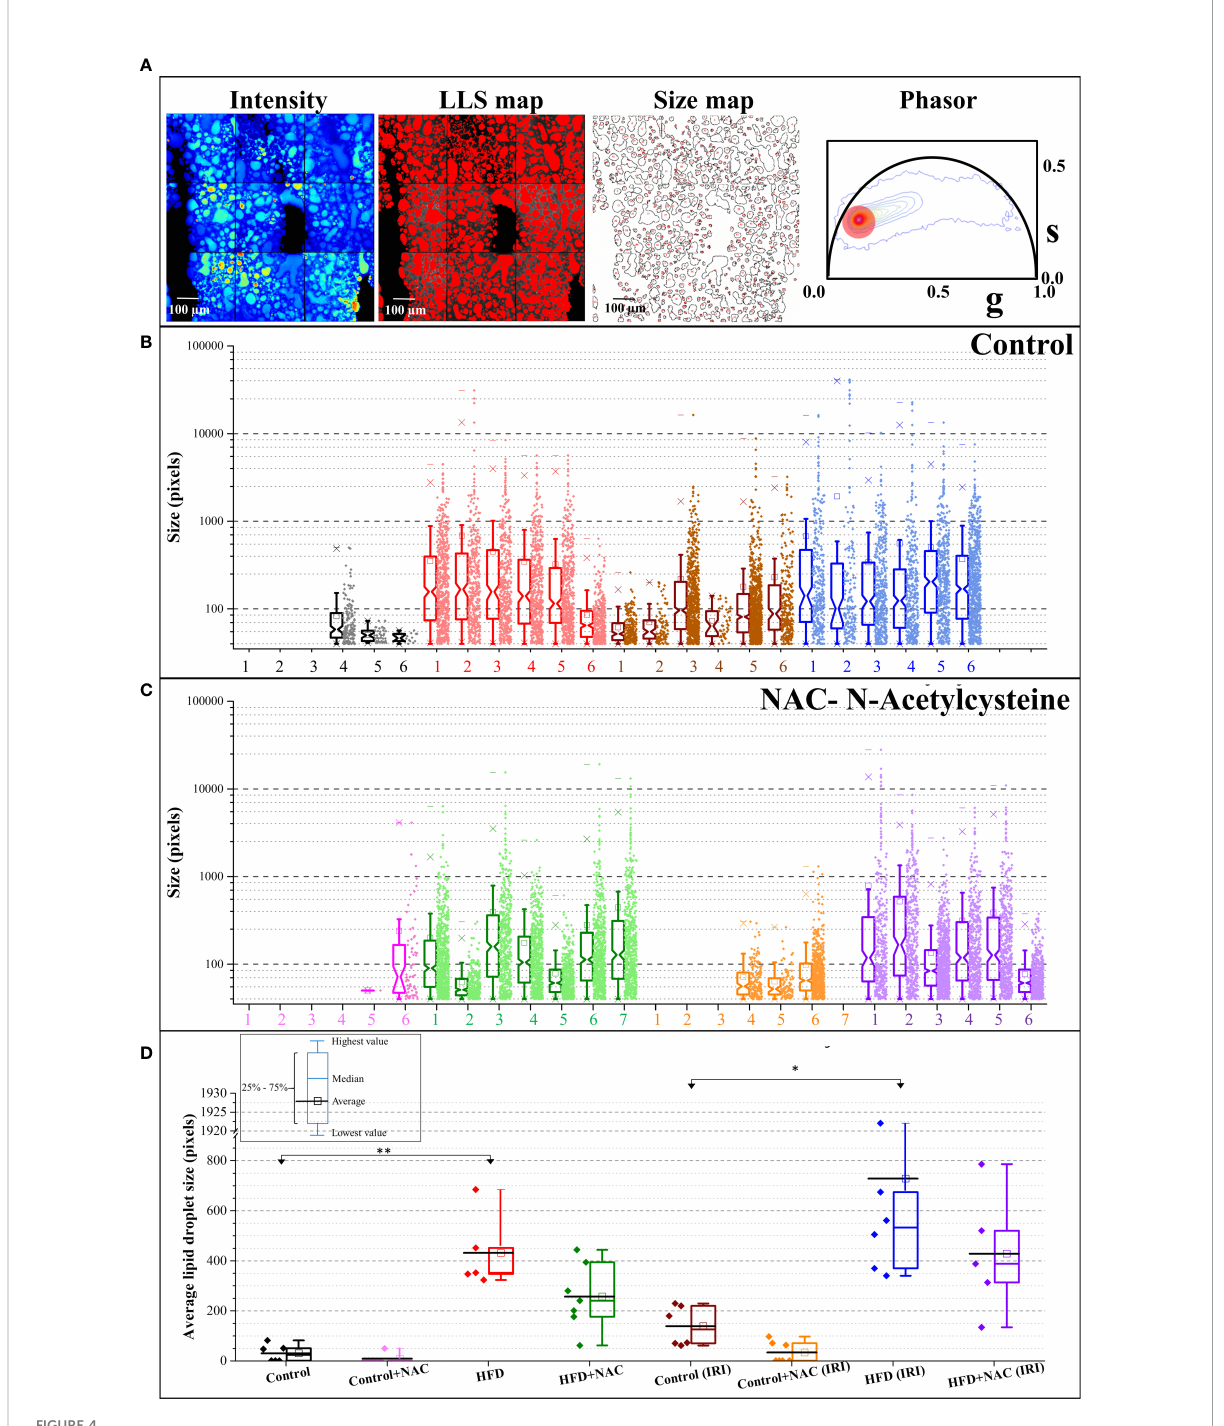
FIGURE 4 NAC treatment signi fi cantly reduced hepatic steatosis in HFD mice. (A) The fl uorescence intensity image, the LLS mapped image, the calculated size distribution maps, and the corresponding phasor plot. The red cursor was used to select the LLS lifetime signature originating from the intensity image and the LLS image was colored according to that phasor signature. The size map was created to show the distribution of the droplets. (B, C) The size map was created to show the distribution of the droplets. (B, C) The size distribution plots for Control (B) and NAC (C) treatment. The Y axis is shown in logscale to exemplify the increasing size as a function of diet and IRI. The distribution shows HFD and IRI induce the large lipid droplets and (especially above 10000 pixels) are lower in number in HFD + NAC, groups. (n=5-7 mice per group). (D) The average size distribution of lipid droplets from the livers of the animals in different feeding regimen. “ * ” 0.05 to 0.01, “ ** ” 0.01 to